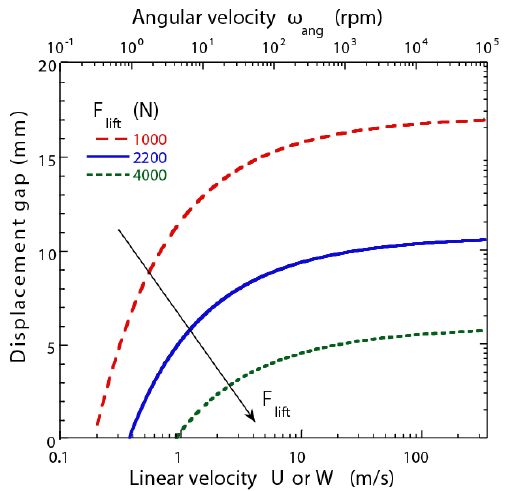
Figure 10. Displacement gap versus speed for three di ff erent Hyperloop pod weights. Bottom abscissa: Linear velocity U of passive maglev; Top abscissa: Angular velocity ω ang of active maglev. (cid:1)